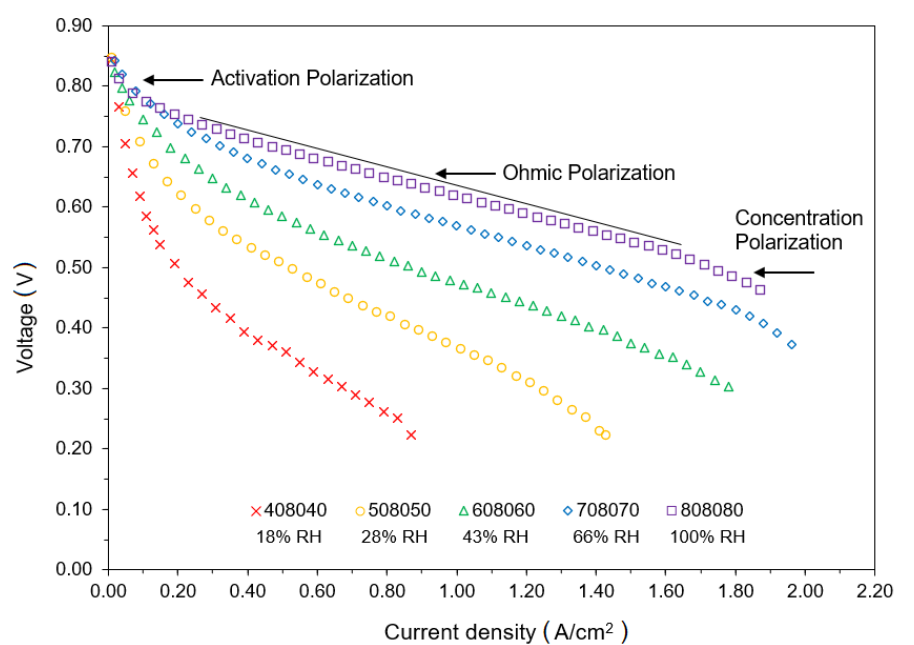
Figure 3. Polarization curves obtainedexperimentally: cell voltage as a function of current density for different relative